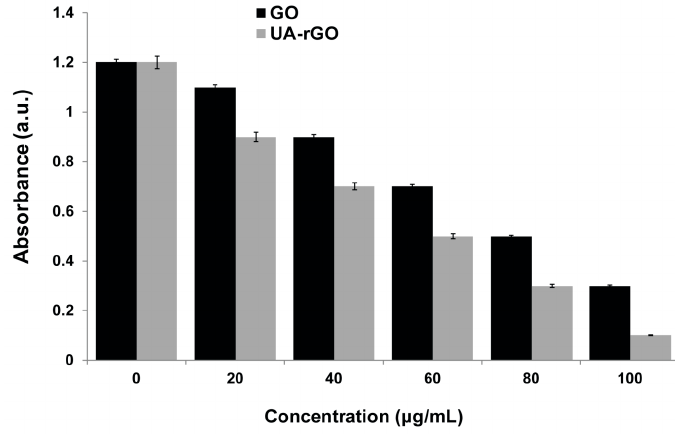
Figure 7. Effects of GO and UA-rGO on the viability of human ovarian cancer cells. The viability of A2780 human ovarian cancer cells was determined after 24 h exposure to different concentrations of GO or UA-rGO using the WST-8 assay. The results are expressed as the mean ± standard deviation of three independent experiments. There was a significant difference in the viability of GO- and UA-rGO-treated cells compared to the untreated cells by the Student’s t -test ( p < 0.05).